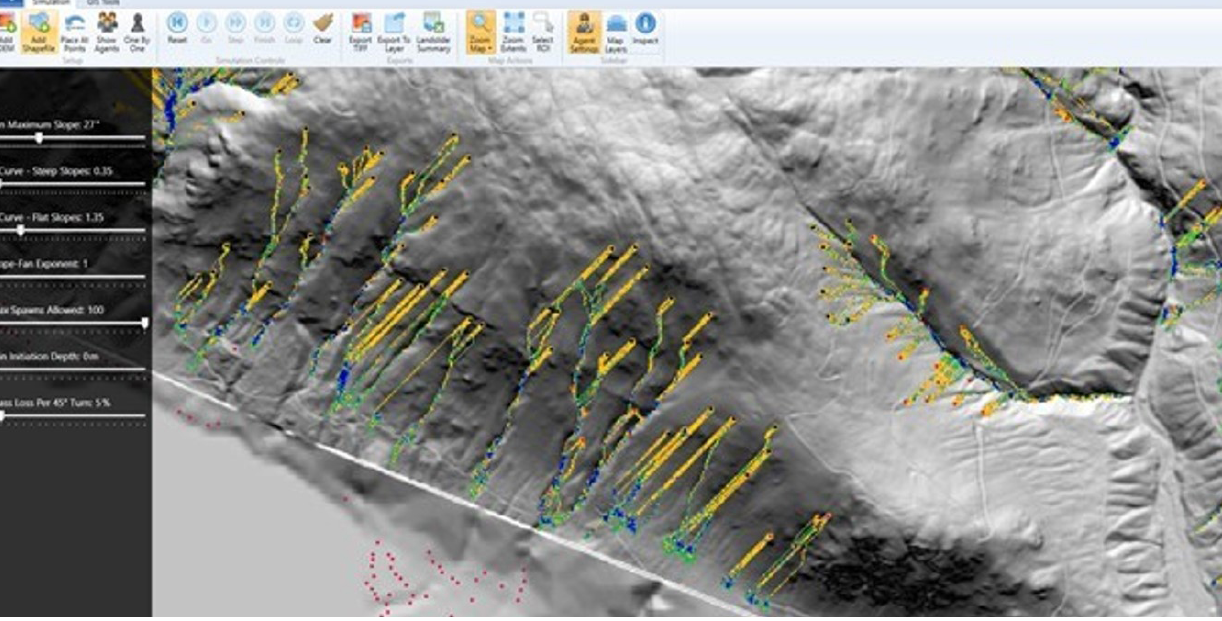
Figure 15. Test run of simulated landslides along the north shore of Lake Cowichan. Yellow represents scour, and green and blue represent deposition (blue is